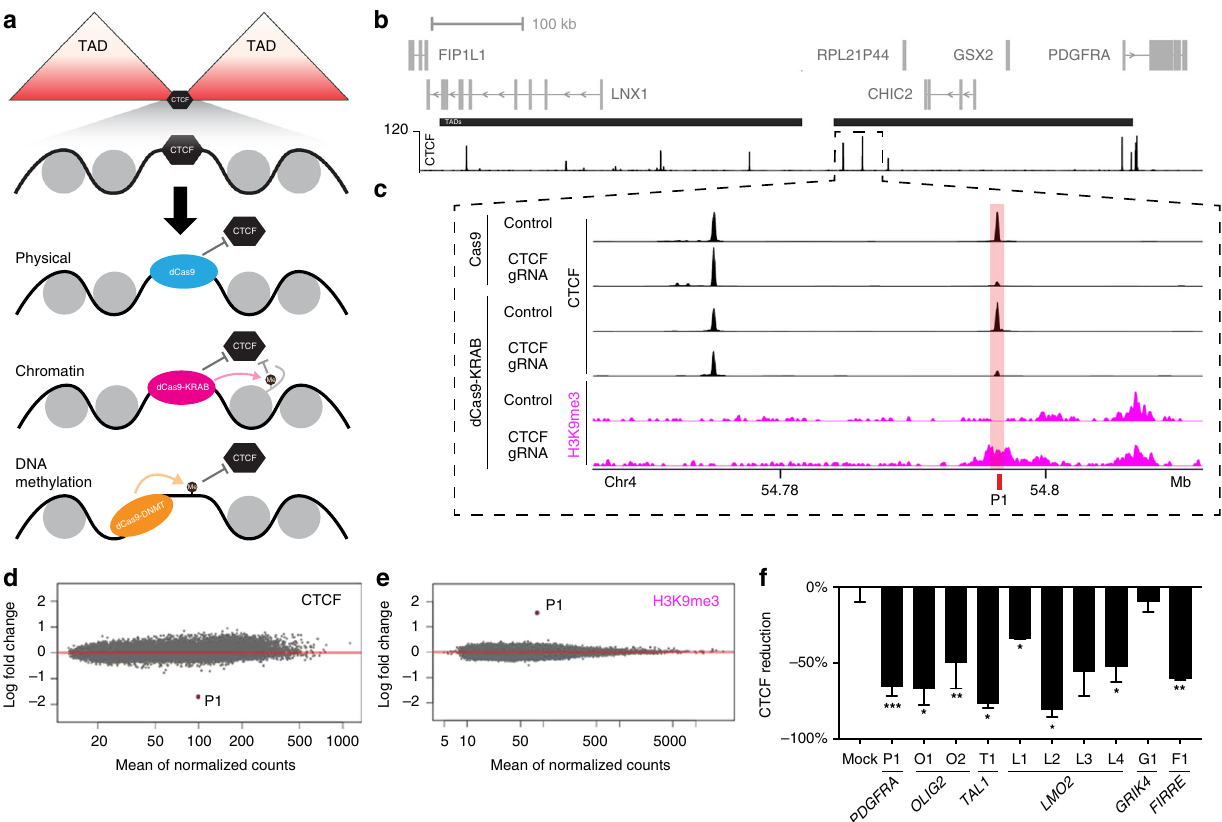
Fig. 1 Epigenome editors can speci fi cally disrupt CTCF binding at topological insulators. a Schematic depicts potential epigenome editing strategies for displacing CTCF from a theoretical insulator separating two TADs. b Genomic view of the PDGFRA locus on chromosome 4 shows genes (gray), two TADs (black bars, middle) and CTCF ChIP-seq signal for HEK293 cells (black, bottom). c Expanded view of the boundary region fl anking the TAD that contains the PDGFRA promoter shows ChIP-seq signals for CTCF (black) and H3K9me3 (pink). CTCF pro fi les are shown for HEK293 cells after epigenome editing by Cas9 or dCas9-KRAB, with gRNA to the PDGFRA insulator P1 CTCF target site (pink shade) or a non-targeting control. H3K9me3 pro fi les are shown for HEK293 cells after epigenome editing by dCas9-KRAB, with gRNA to the PDGFRA insulator P1 CTCF target site or a non-targeting control. d , e Plots show differential ChIP-seq signals for CTCF ( d ) or H3K9me3 ( e ) over all CTCF peaks genome-wide, in cells expressing dCas9-KRAB with P1 targeting gRNA (relative to control). Each point represents the log fold change in normalized read counts observed at that locus, ordered by the mean count observed across all conditions. CTCF occupancy is reduced and H3K9me3 is increased speci fi cally over the targeted P1 CTCF site. f Bar plots show change in CTCF occupancy measured by ChIP-qPCR over indicated CTCF sites following transient transfection with dCas9-KRAB and indicated gRNA (see also Fig S1). CTCF disruption by epigenome editing is robust across the ten individually targeted loci. Data are normalized to non-targeting controls. Error bars, mean ± s.e.m. * P < 0.05, ** P < 0.01, *** P < 0.001 by Student ’ s t -test. n = 4 (P1 and O1) or 2 (other loci) biological replicates, respectively. Source data for 1f are provided as a Source Data fi le, ChIP-seq and RNA-seq data can be found via GEO accession